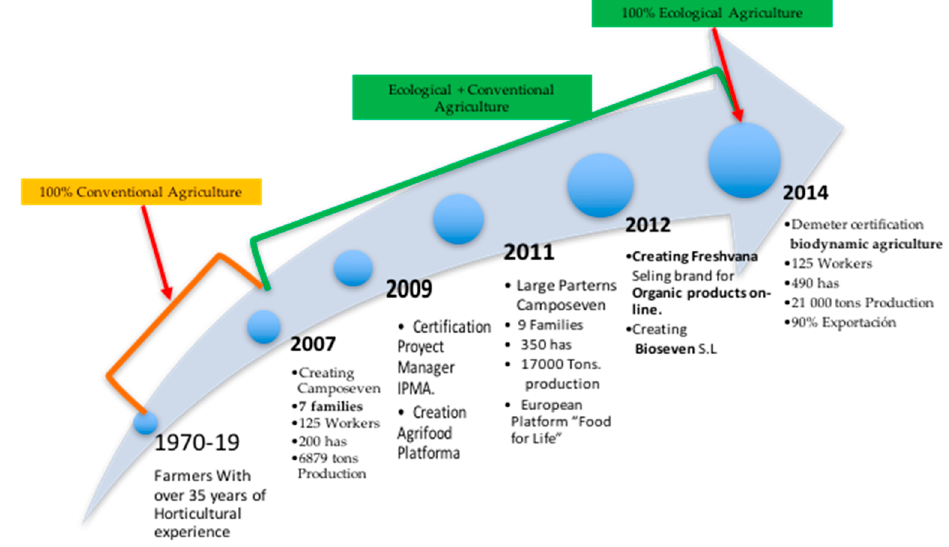
Figure 1. Important milestones in the evolution of the Organic Cooperative. Source: [38].